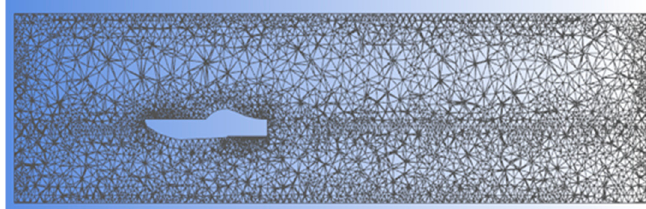
Figure 3. Mid-section mesh after mesh adaptation.